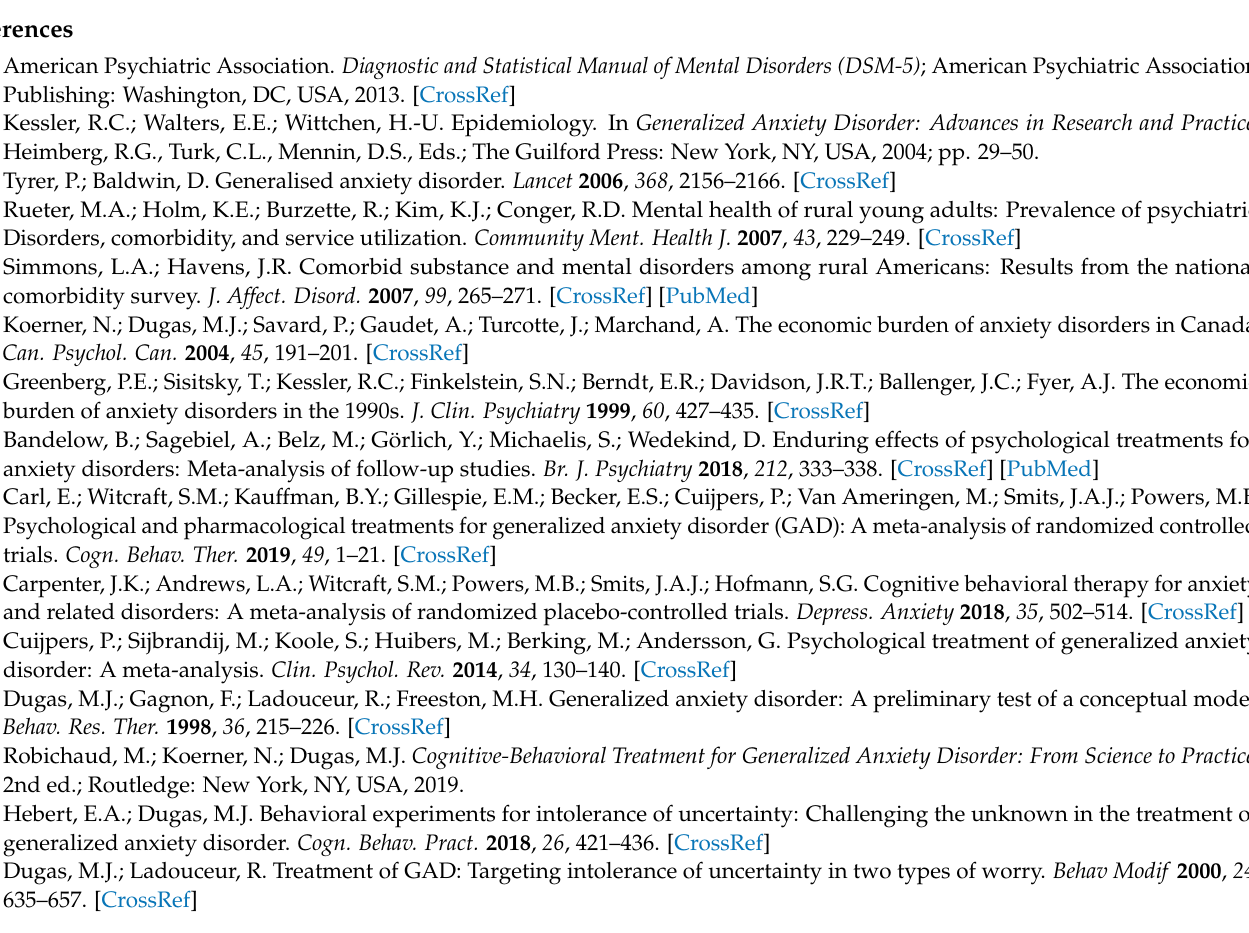
Figure A1. Illustration of the impact of cognitive-behavior therapy delivered by videoconference or face-to-face based on Estimated Marginal Means from Multilevel Linear Models.